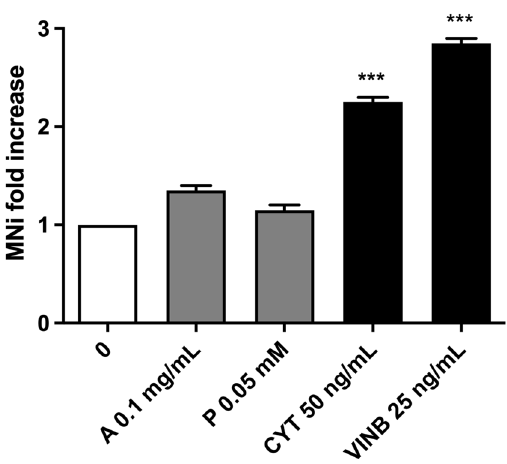
Figure 5. MNi fold increase on TK6 cells after 3 h treatments with A. leucotrichus (A), perillaldehyde ( p ), or positive controls (CYT, VINB) followed by 23 h of recovery in the complete medium at the indicated concentrations compared to the untreated cultures (0). *** p < 0.001 vs. 0.